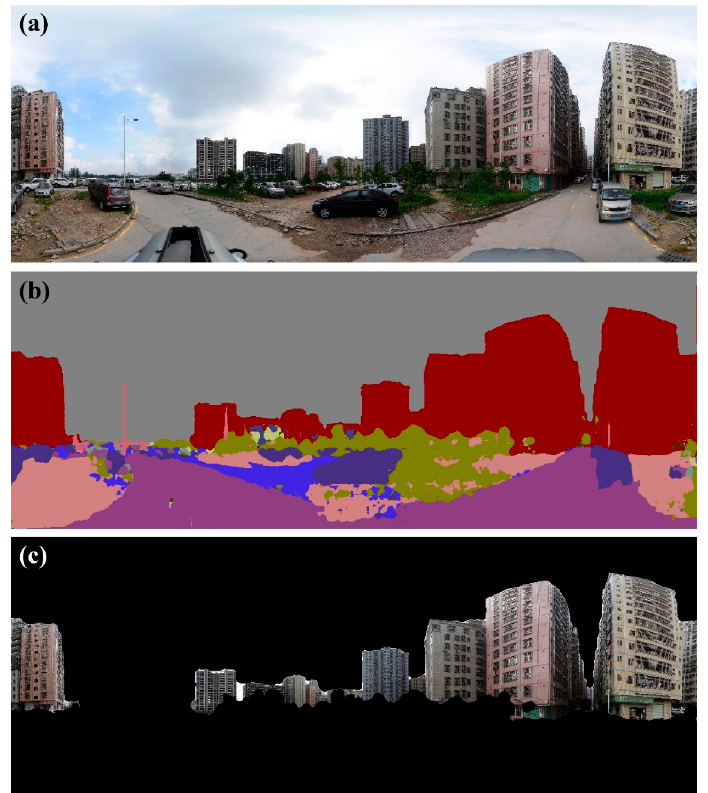
Figure 4. An illustration of the urban façade extraction from street-view imagery with the deep learning-based method. ( a ) An example of a BSV panorama in the study area, ( b ) results of seman- tic image segmentation with red polygons indicating the image area of the urban façade, ( c ) results of the extracted urban façade image.